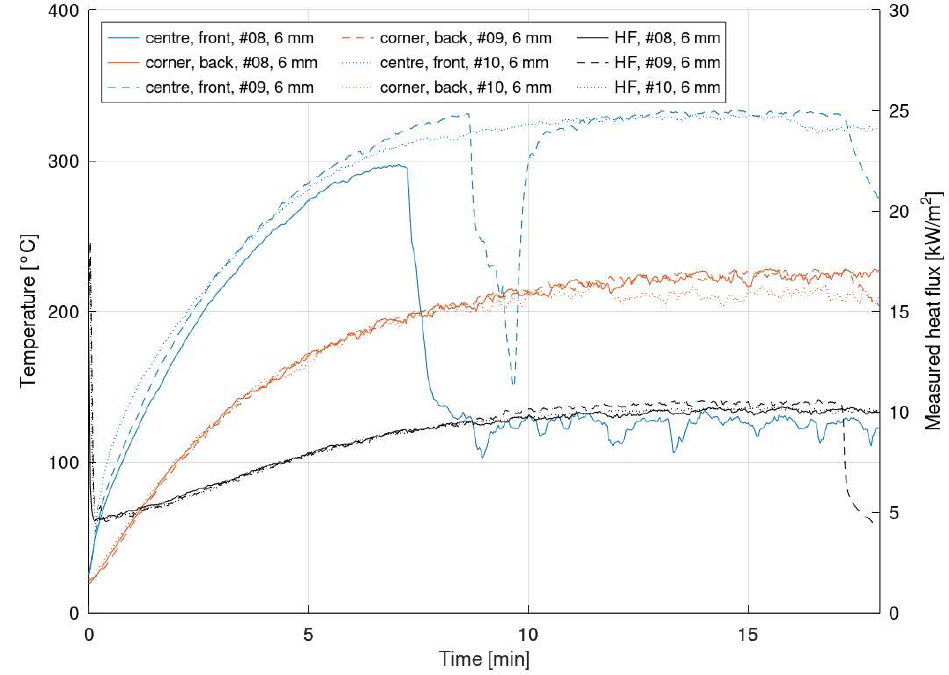
Figure 10. Temperature development and measured heat flux for 6 mm thick FT specimens for studying the effect of low-e coating (Test #8, #9 and #10). Note that connection problems for centre TC in test #8 and #9.